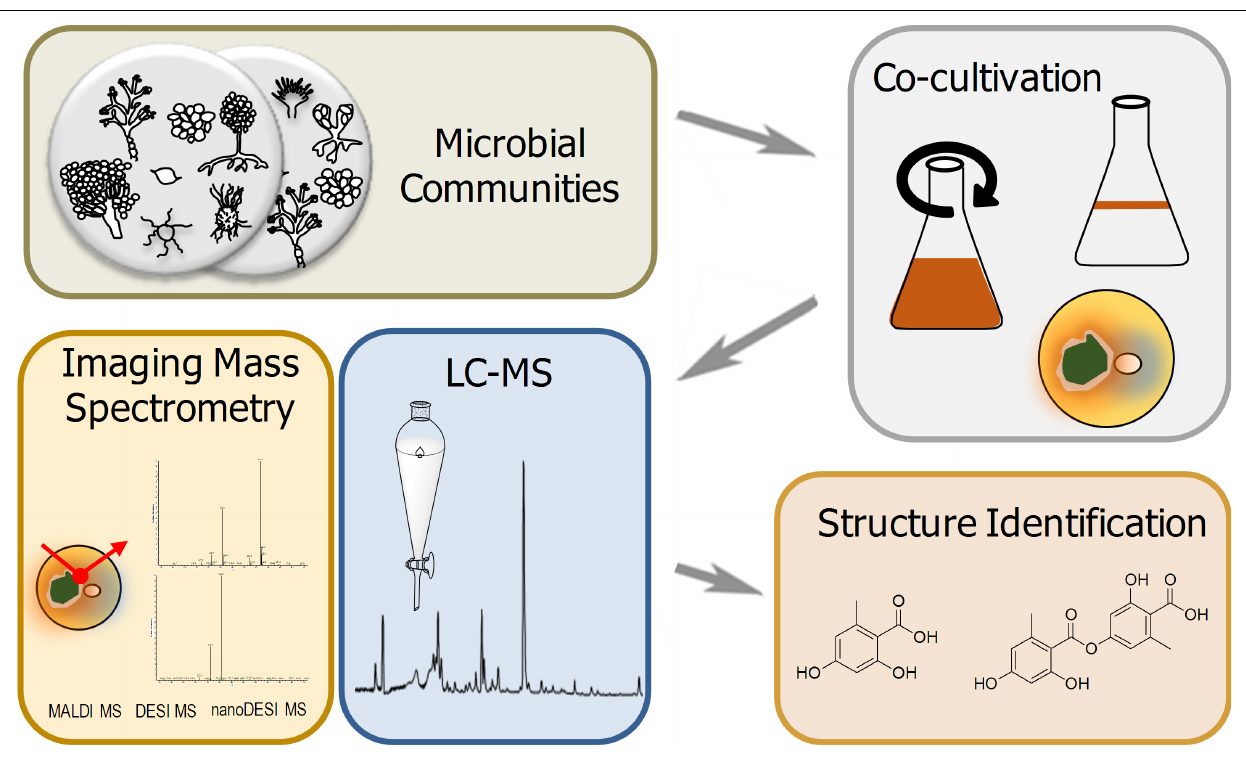
FIGURE 3 | Proceeding of natural product analysis from microbial co-cultivations. Microbial communities are co-cultured in flasks (static or planktonic) or on plates (solid-state culture). Primary analysis of natural products